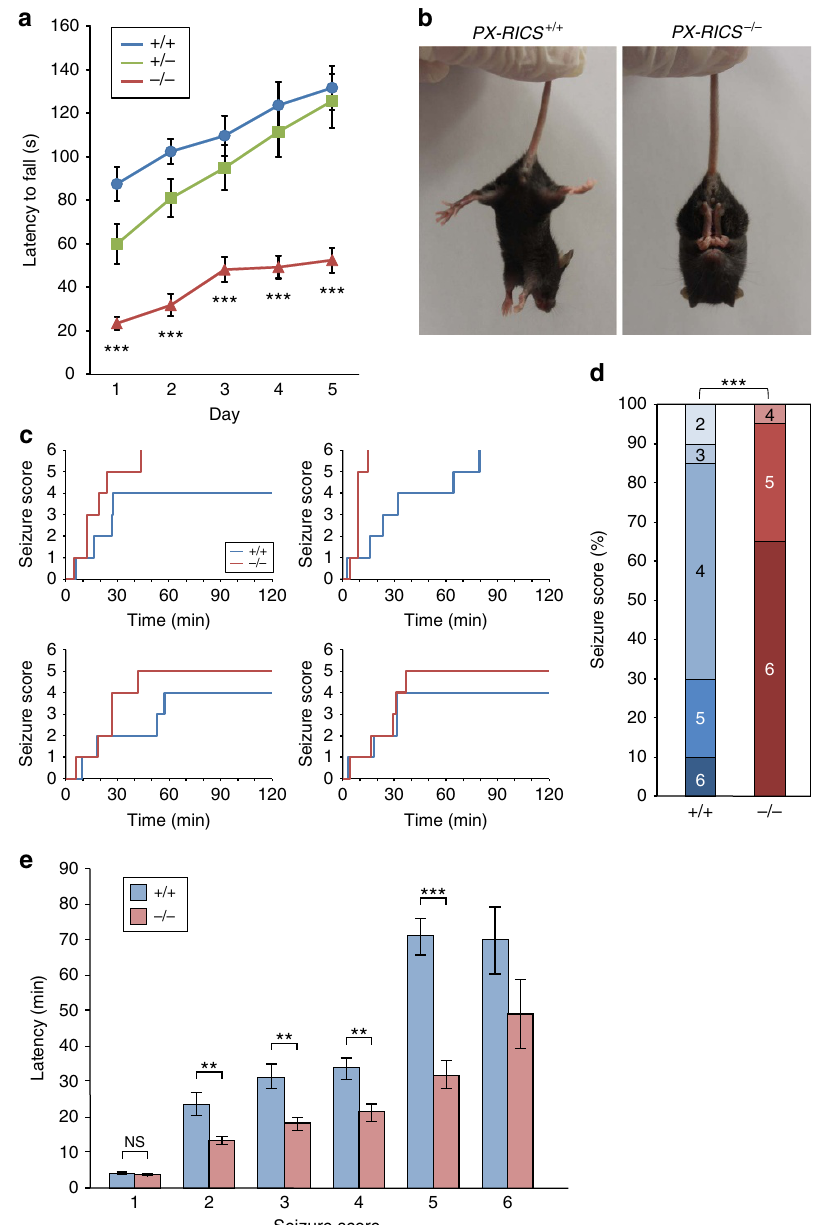
Figure 2 | PX-RICS (cid:2) / (cid:2) mice display impaired motor coordination and a seizure-prone phenotype. ( a ) Accelerating rotarod test. PX-RICS (cid:2) / (cid:2) mice showed poor motor coordination. ( b ) Limb-clasping behaviour in PX-RICS (cid:2) / (cid:2) mice. When picked up by the tail, PX-RICS þ / þ mice splayed their limbs outwards away from the abdomen. In contrast, PX-RICS (cid:2) / (cid:2) mice continuously held all four limbs together in a bat-like posture. ( c – e ) Increased susceptibility to kainate-induced epileptic seizures in PX-RICS (cid:2) / (cid:2) mice. ( c ) Representative time-dependent progression of seizure severity in four pairs of PX-RICS þ / þ and PX-RICS (cid:2) / (cid:2) littermates. ( d ) A breakdown of the maximum seizure severity in PX-RICS þ / þ and PX-RICS (cid:2) / (cid:2) mice. ( e ) Latency for each seizure stage. Significant differences were not determined in latency to score 6 due to the small number of PX-RICS þ / þ mice that reached the stage. n ¼ 20 ( PX-RICS þ / þ ) and 20 ( PX-RICS (cid:2) / (cid:2) ). Data are represented as means ± s.e.m. NS, not significant; ** P o 0.01; *** P o 0.001. Two-way analysis of variance with Bonferroni’s post hoc test ( a ), w 2 -test ( d ) and unpaired two-tailed Student’s t -test ( e PX-RICS (cid:2) / (cid:2) cortical neurons, surface fluorescence was neurons, suggesting that the reduction in surface g 2 EP in markedly reduced, but total fluorescence in pH 7.4 NH 4 Cl- PX-RICS (cid:2) / (cid:2) neurons is due to impaired trafficking to the containing buffer was similar to that in PX-RICS þ / þ neurons plasma membrane, not to enhanced endocytic withdrawal of (Fig. 3a). Quantification of the fluorescence intensities revealed surface g 2 EP (Supplementary Fig. 3e–h). The cell surface labelling and surface biotinylation assays revealed that surface-expressed that the amount of surface-expressed g 2 EP is markedly decreased g 2 is markedly reduced in PX-RICS (cid:2) / (cid:2) hippocampal neurons in PX-RICS (cid:2) / (cid:2) neurons (Fig. 3b). This result was confirmed by the cell surface labelling and surface biotinylation assays (Supplementary Fig. 3a,b). Internalization activity for g 2 was Fig. 3a,c,d). Taken together, we concluded that surface similar between the PX-RICS þ / þ and PX-RICS (cid:2) / (cid:2) cortical expression of GABA A Rs is impaired in PX-RICS (cid:2) / (cid:2) neurons.